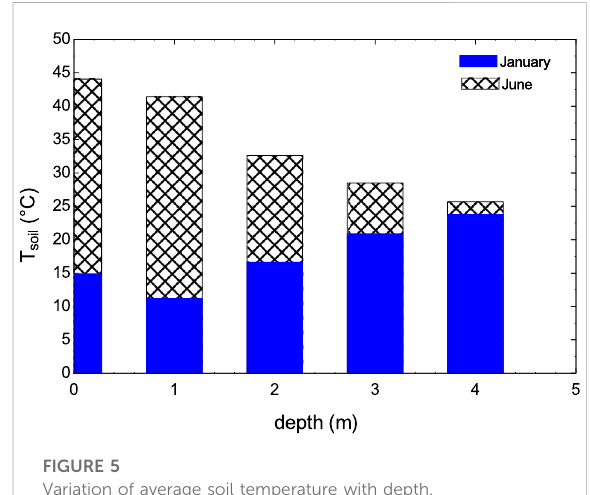
FIGURE 5 Variation of average soil temperature with depth.